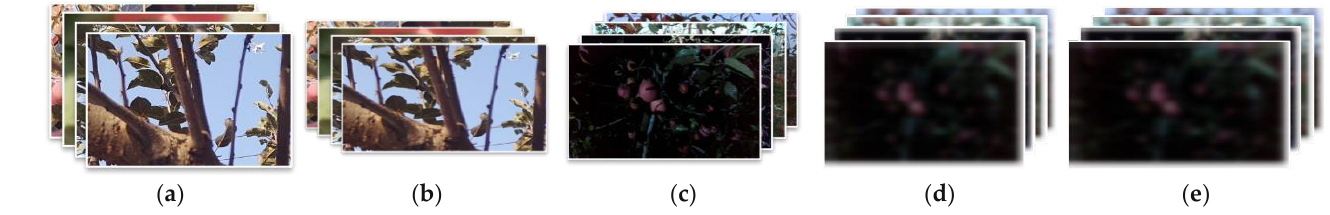
Figure 4. Various base images with high and low illuminations: ( a ) 640 × 480 base image under high illumination; ( b ) 1280 × 720 base image under high illumination; ( c ) 1280 × 720 base image under low illumination; ( d ) 640 × 480 blurred base image under low illumination; ( e ) 1280 × 720 blurred base image under low illumination.